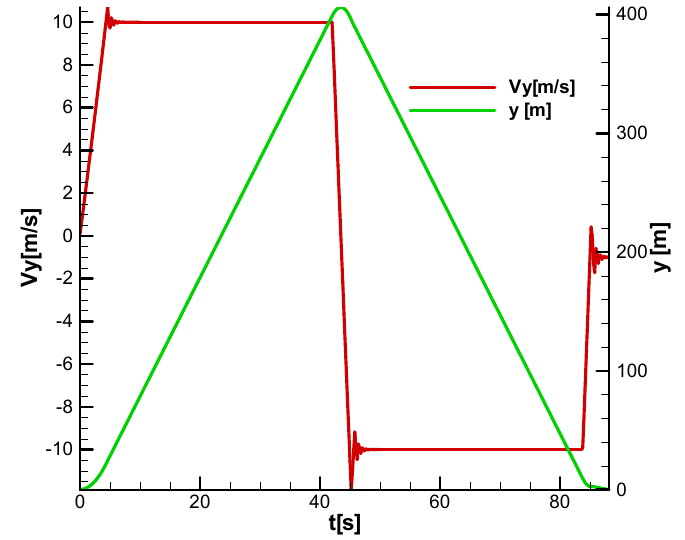
Figure 13. Vertical velocity and altitude.